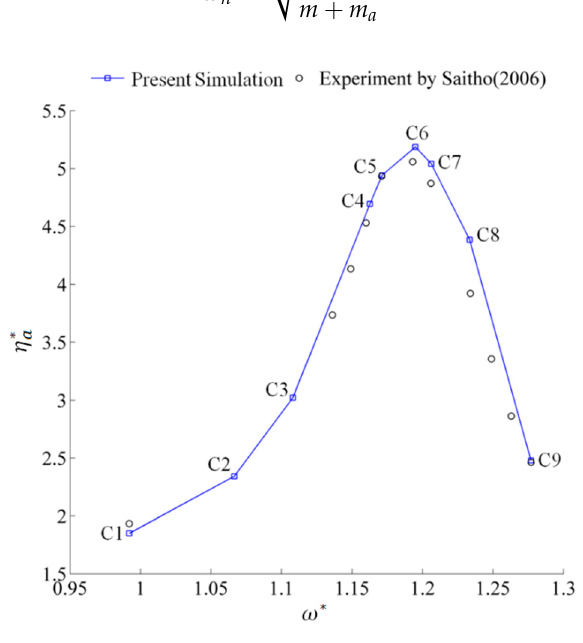
Figure 6. The comparison of the present numerical results and the experimental data by Saitoh [1] in terms of the free surface elevations in the gap ( η ∗ a ) ( B ∗ g = 0.1 ).